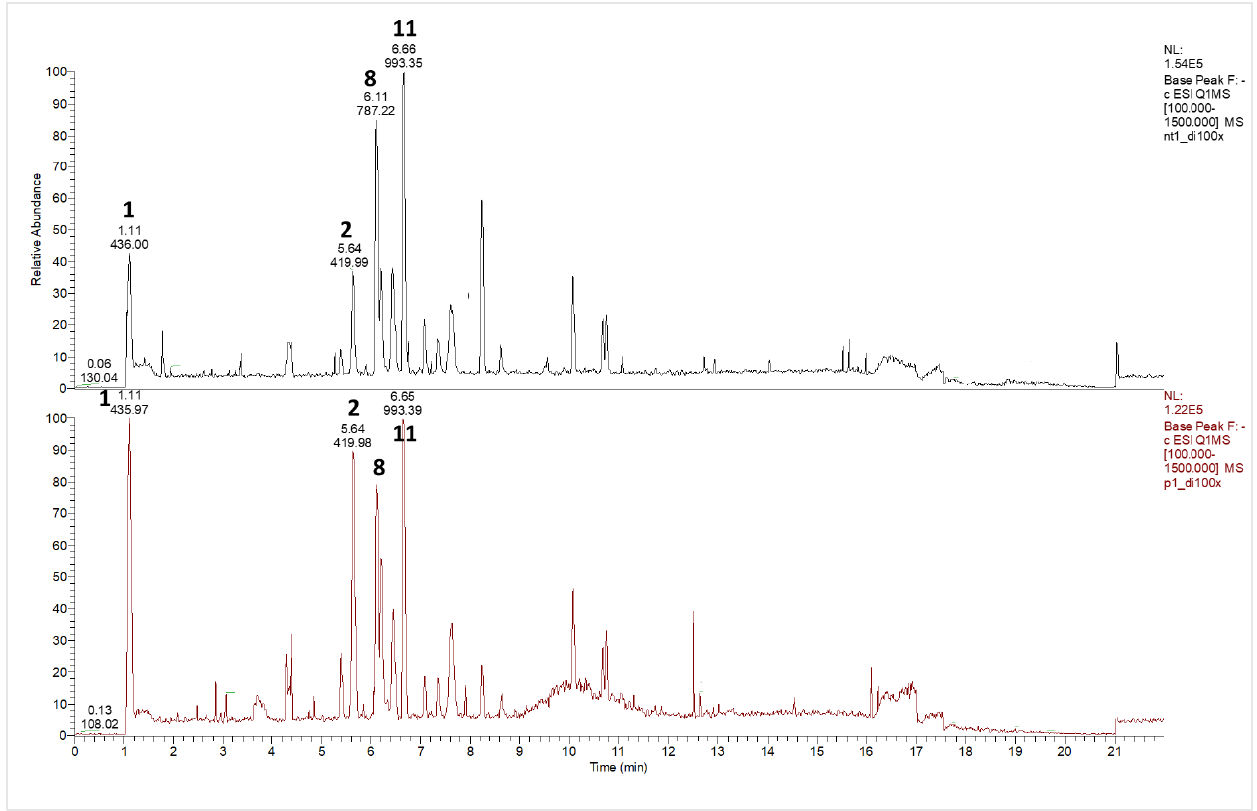
Figure 1. UHPLC-MS/MS full-scan chromatograms (RT: 0.00 – 21.99 min) of the methanolic extracts of rocket salad, washed in PAW for 20 min (PAW-20, in red) or untreated sample (UT, in black). Numbers indicate the most abundant peaks (as relative ion abundance), and their corresponding names are reported in Table 2. Chromatographic peak detection for [M-H] − at m/z 436 (peak 1), 420 (peak 2), 787 (peak 8), and 993 (peak 11) are reported in Supplementary File